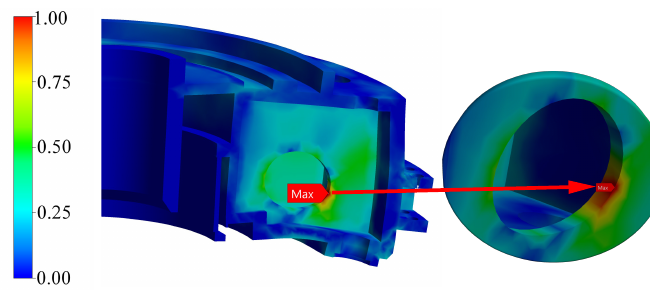
Figure 16. The maximum stress of the head cover during turbine start-up.